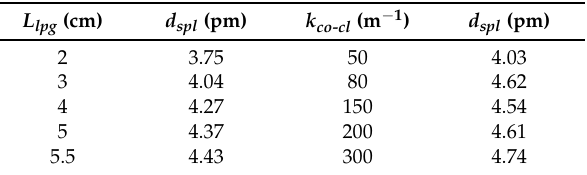
Figure 8. Transmission spectra of different LPGRRs characterized by the same length equal to 3 cm and period of 311 µm, as a function of the core-to-cladding coupling coefficients varied in the range of 50–300 m −1 . Table 4. Distance between the splitting resonances as a function of the LPG length and the core-to-cladding coupling coefficient.